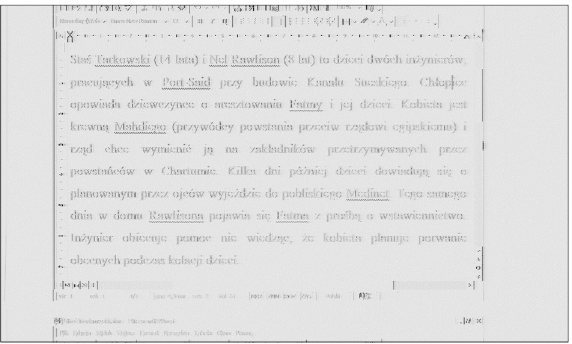
Figure 1. An example of a reconstructed image from a source of compromising emanations in VGA analogue standard form (reception frequency f o = 650MHz, BW = 20MHz; sampling frequency f s = 62.5MS/s ) inversion of the